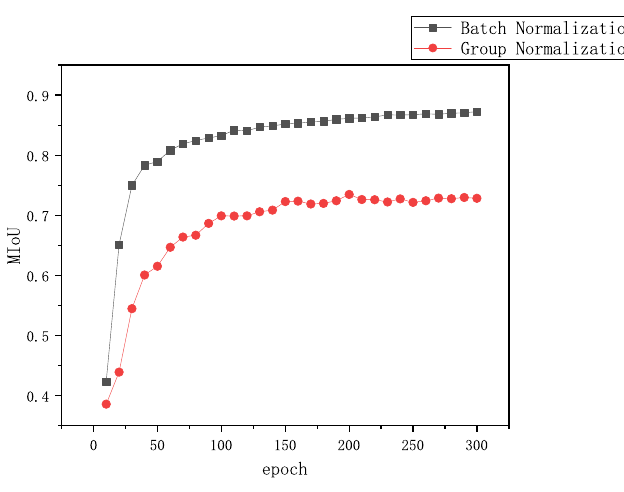
Figure 10. MIoU result on the validation set over the model normalized by BN and